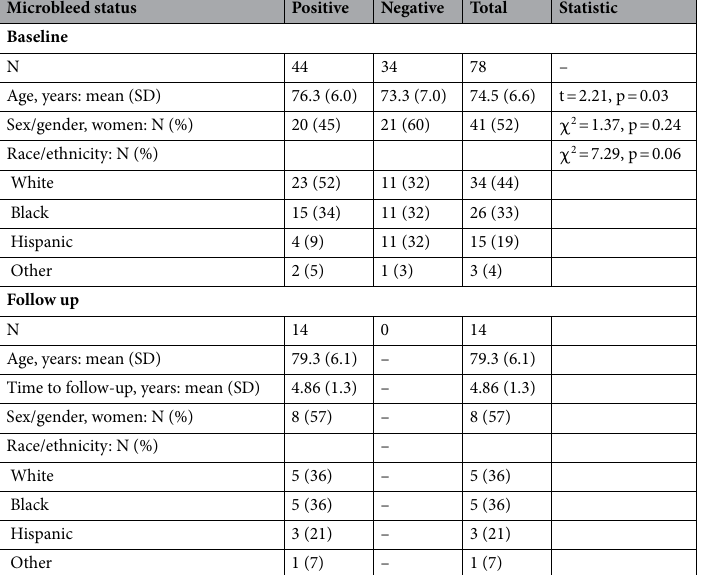
Table 1. Demographic characteristics of individuals with and without microbleeds. Microbleed positive participants are those who have at least one microbleed present (identified by two or more raters), and microbleed negative participants are those who have no microbleeds present (agreed by all three